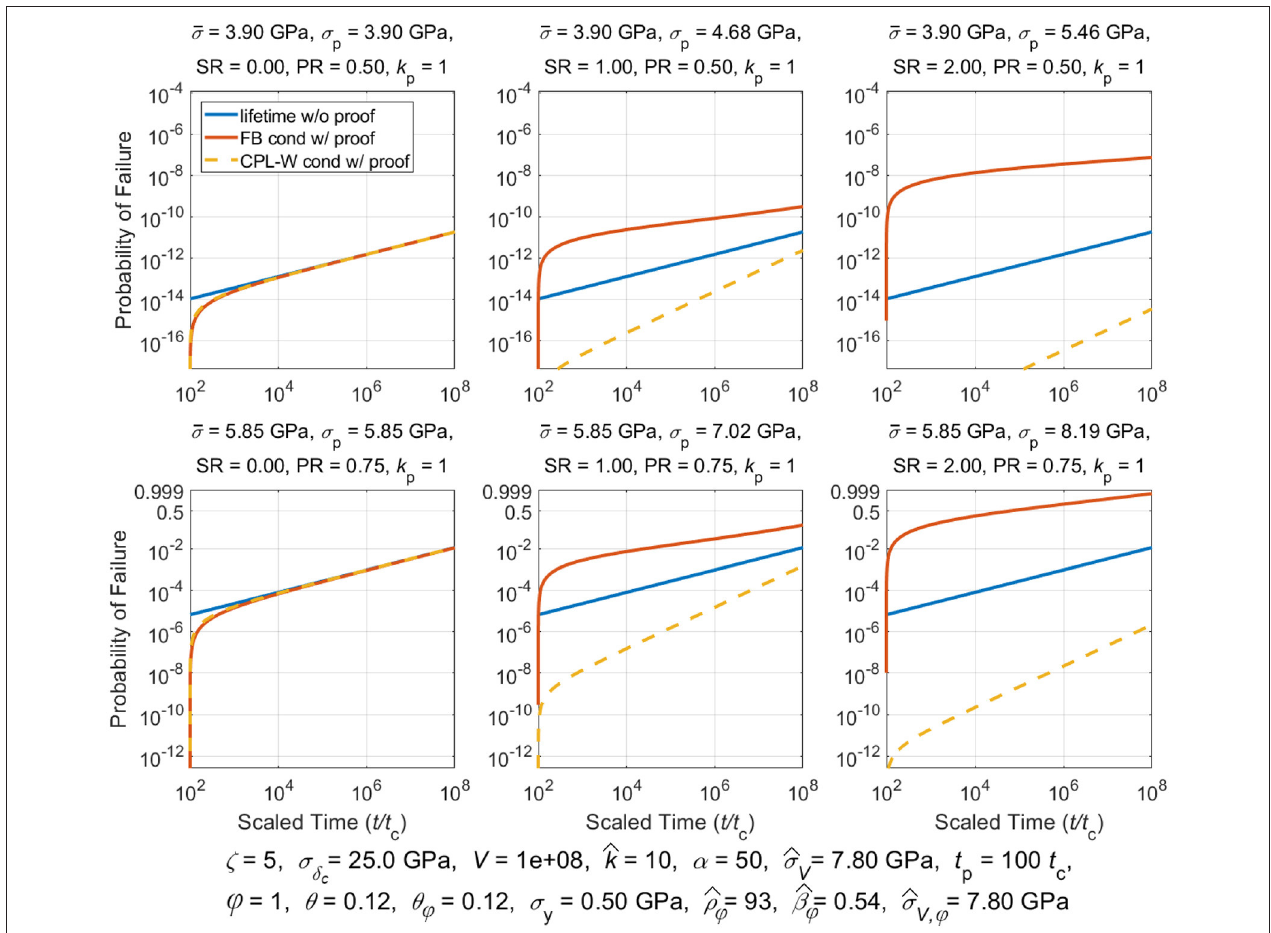
FIGURE 1 | Tows with fibers in a planar array and with matrix parameter, ϕ